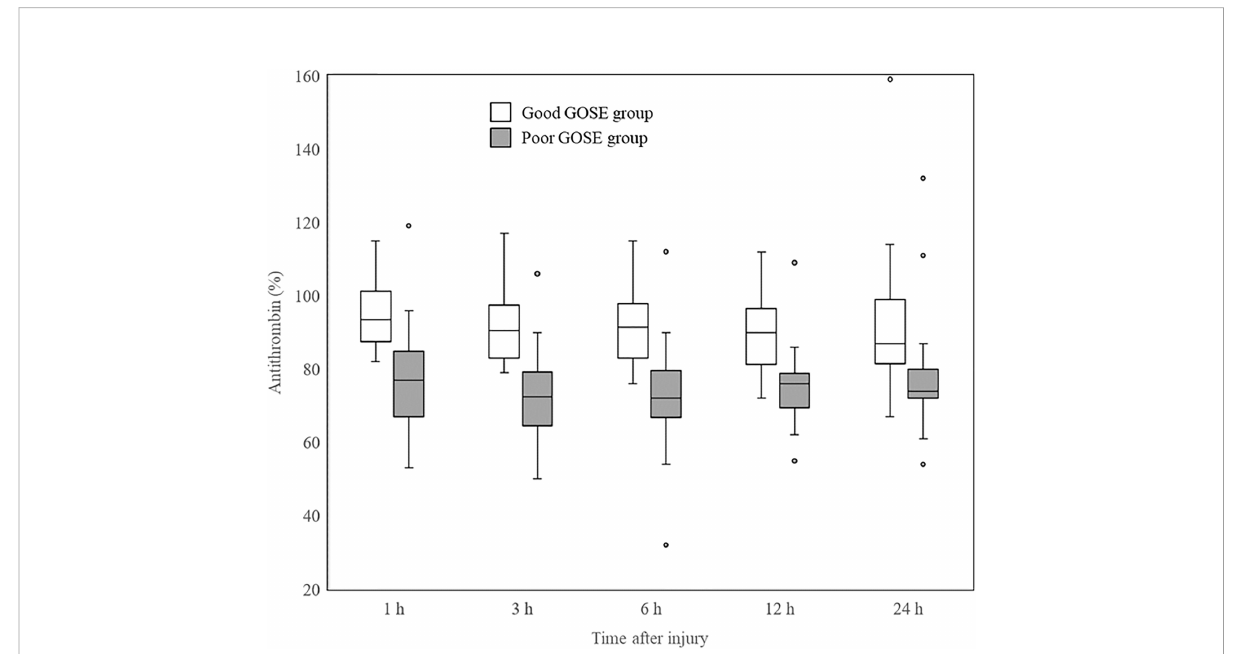
FIGURE 2 Changes in AT activity levels of each GOSE group after injury. Signi fi cant differences between good (white box) and poor (gray box) GOSE groups at all the time points are shown in AT activity levels. Neither group showed a signi fi cant change in AT activity levels after injury (good GOSE group, Friedman test, c 2 = 3.59, df = 4, p = 0.464; poor GOSE group, Friedman test, c 2 = 2.83, df = 4, p = 0.587). Horizontal bars, boxes, whiskers, and dots represent the median, interquartile range, a distance of 1.5 times the interquartile range, and outliers, respectively. AT, antithrombin; GOSE, Glasgow Outcome